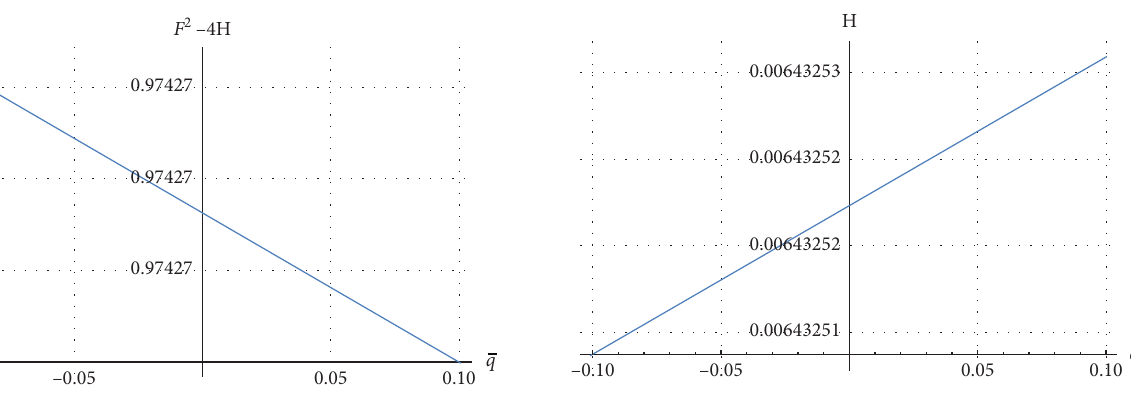
Figure 7: Condition (47), F 2 —4H > 0 is satisfied for − 0 . 1 ≤ q ≤ 0 . 1.